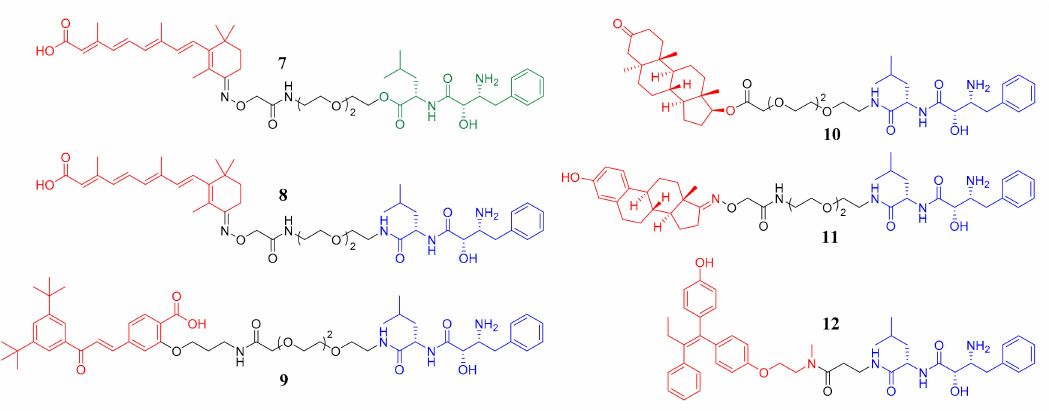
Figure 2. The structures of reported bestatin-based SNIPERs. The target protein binding parts are in red, the linker parts are in black and the bestatin ester and bestatin amide are in green and blue, respectively.